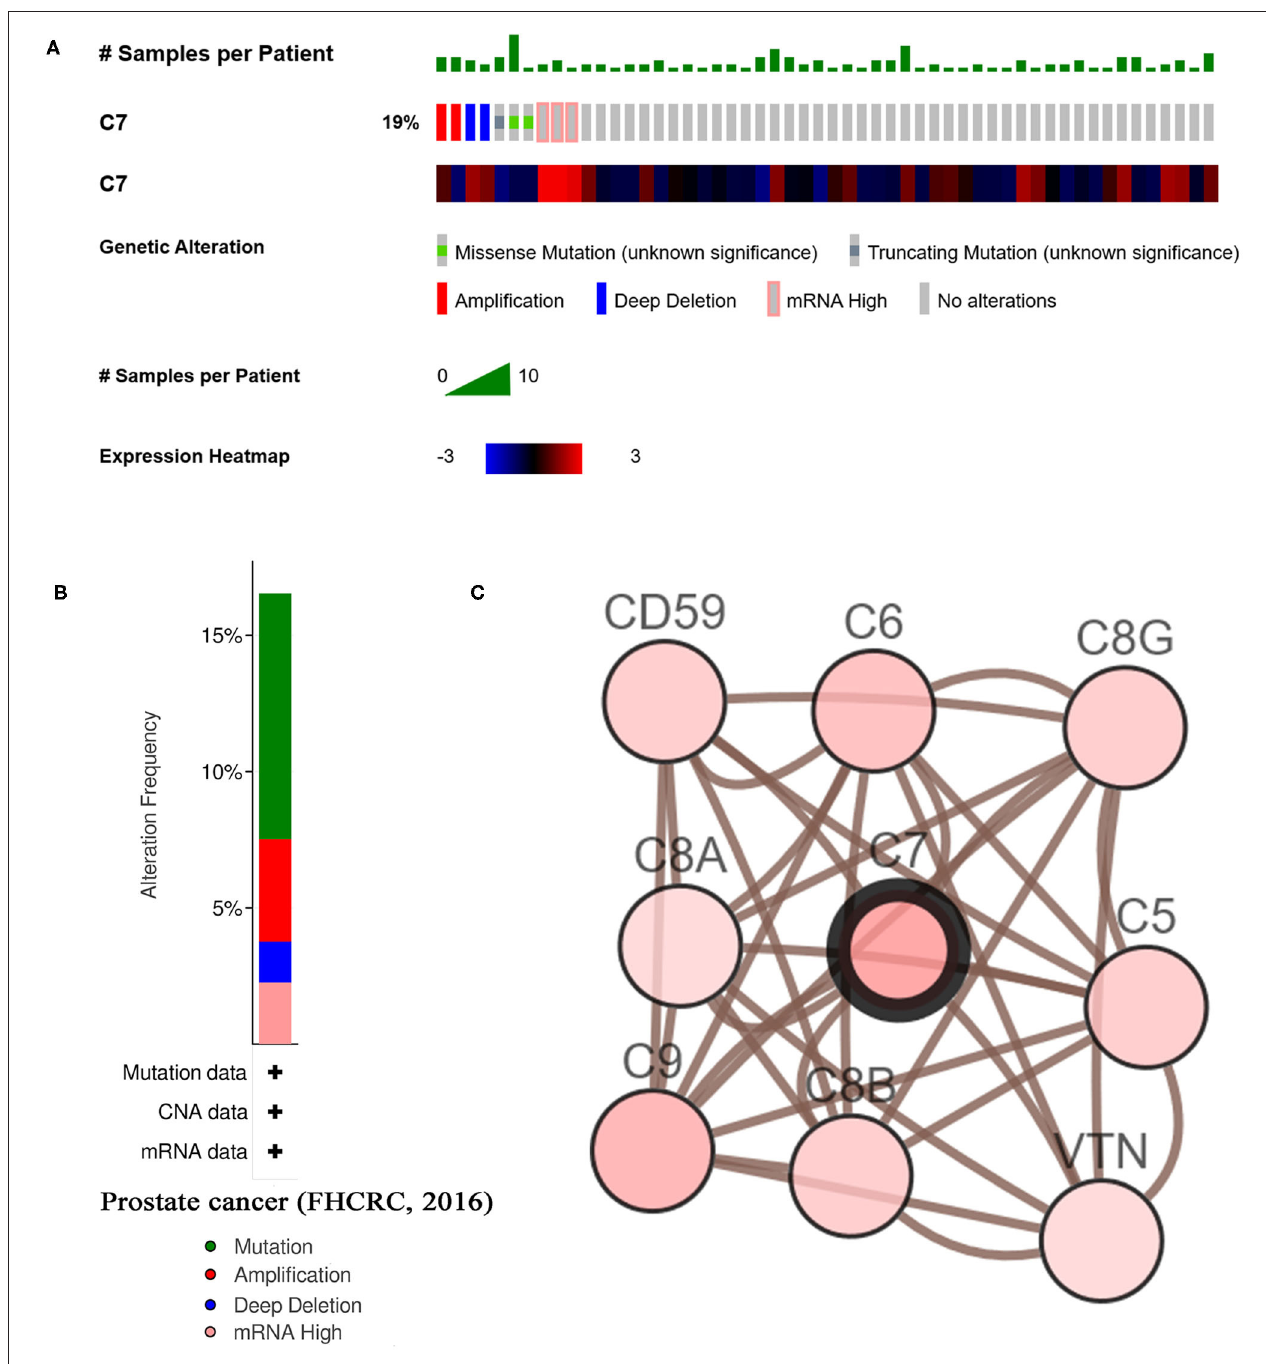
FIGURE 7 | A summary of mutations and CNVs of hub genes. (A) Genetic alterations associated with C7 and expression heatmap of C7 based on the data from FHCRC. (B) The total alteration frequency of C7 in FHCRC is illustrated. (C) The network contains 9 nodes, including C7 and the 8 most frequently altered neighbor genes. Relationship between hub gene and tumor drugs is also illustrated.